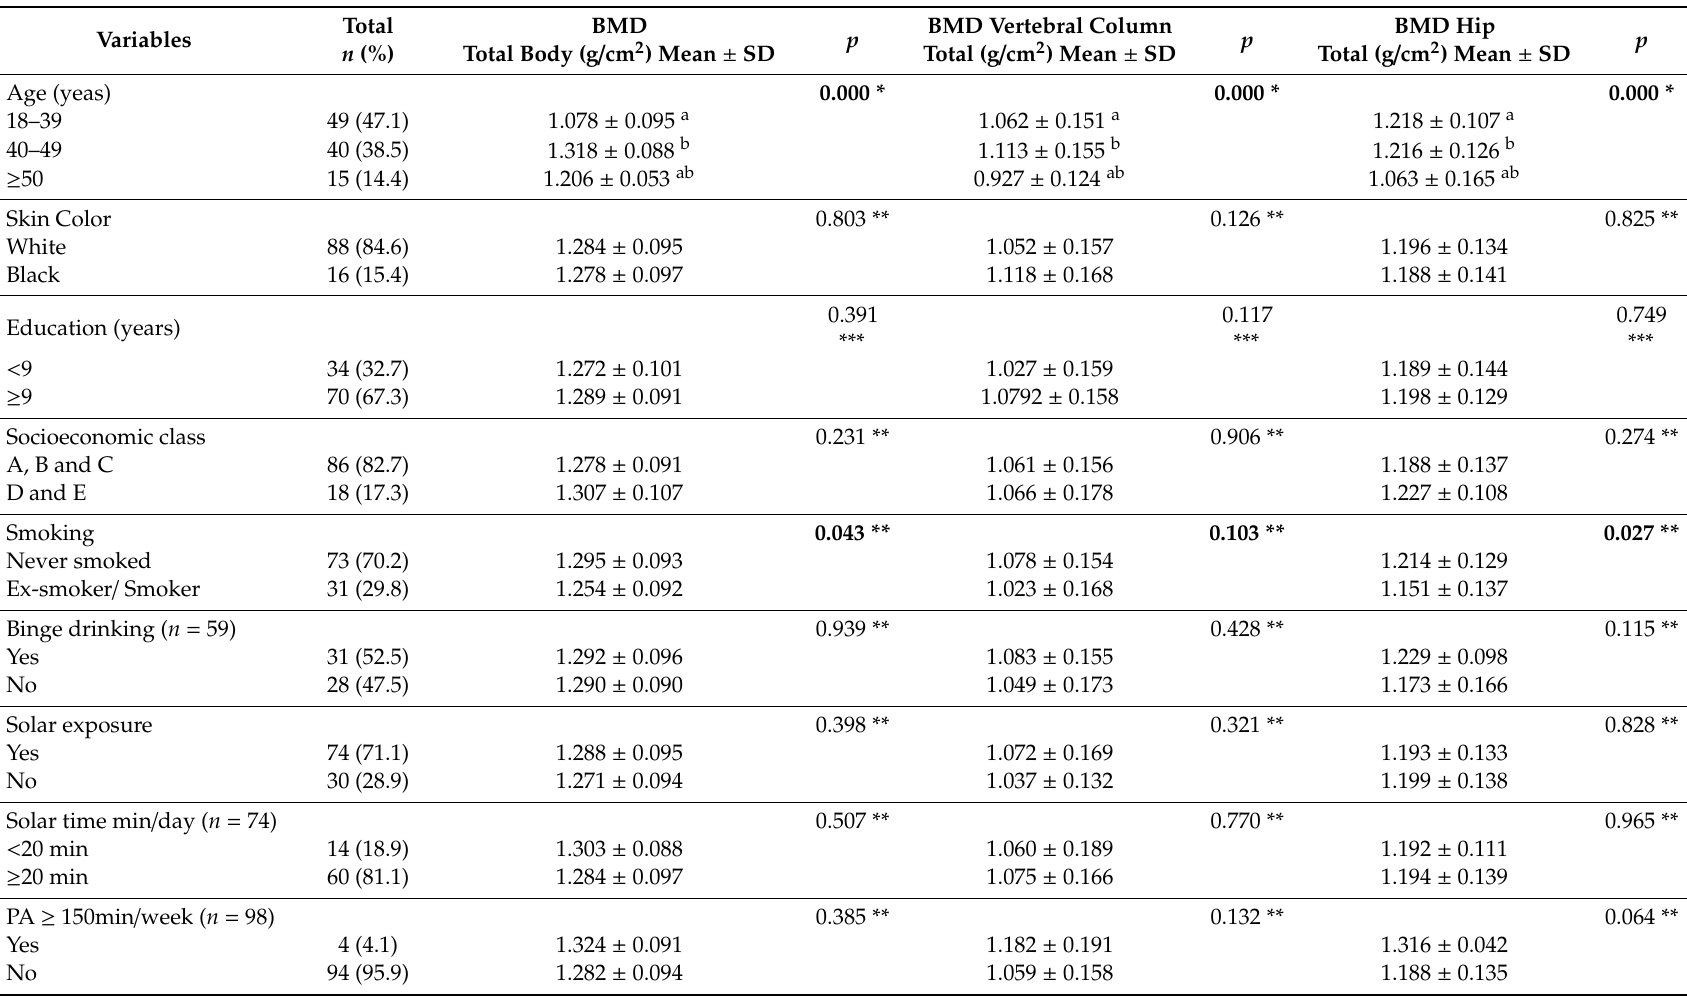
Table 2. Associations between three bone mineral density (BMD) sites with sociodemographic variables, lifestyle and clinical conditions in severely obese women, DieTBra Trial, 2016 ( n =